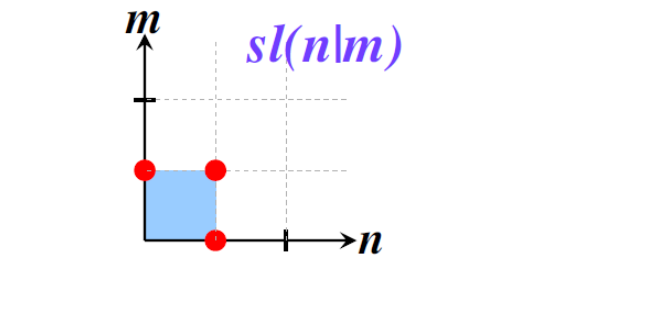
Figure 2 . The three corners (red (cid:15) ) correspond to the three special values of N = (cid:0) 1 ; 0 and 1 in H (cid:3) ; (cid:3) ( K ) theory with color (cid:21) = (cid:3) N